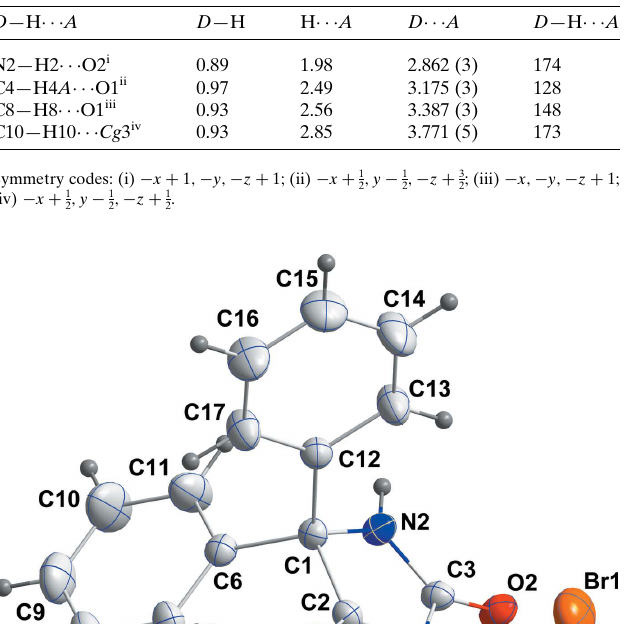
Table 1 Hydrogen-bond geometry (A˚ , (cid:2) ). Cg 3 is the centroid of the C12–C17 benzene ring.